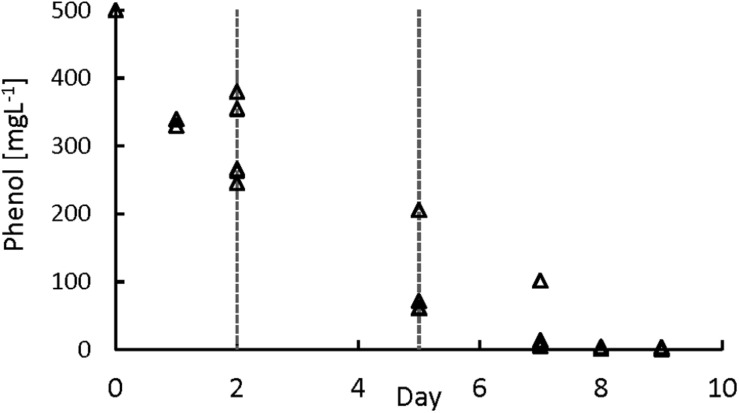
Phenol degradation batch assays. The lines represent the period used for the determination of the specific phenol conversion rate.